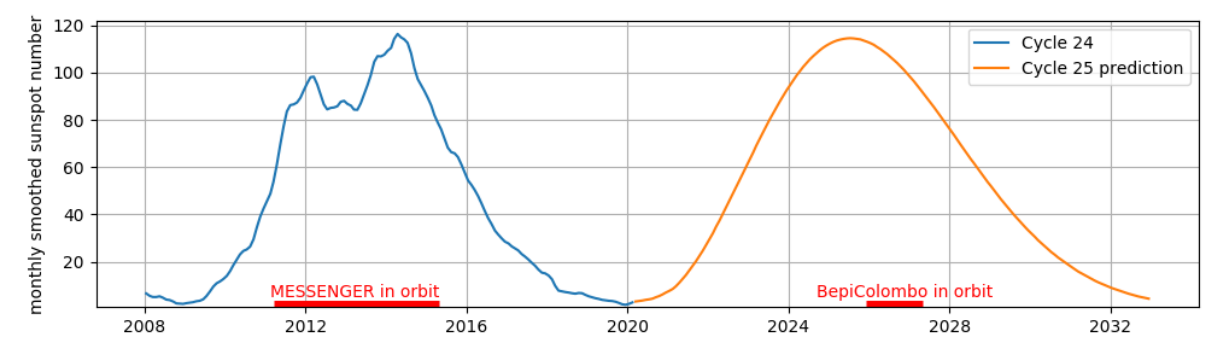
Figure 2. Monthly smoothed sunspot numbers from January 2008 to August 2020 in blue [37] and the prediction of solar cycle 25 in orange [38], which expects the next solar maximum in July 2025 with an uncertainty of 8 months. The periods that MESSENGER and BepiColombo are in orbit around Mercury are indicated in red on the x-axis. The period indicated for BepiColombo is the nominal mission duration of 1